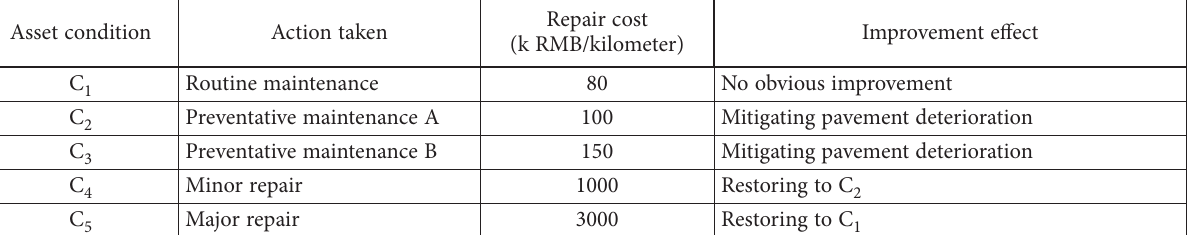
Repair cost (k RMB/kilometer)